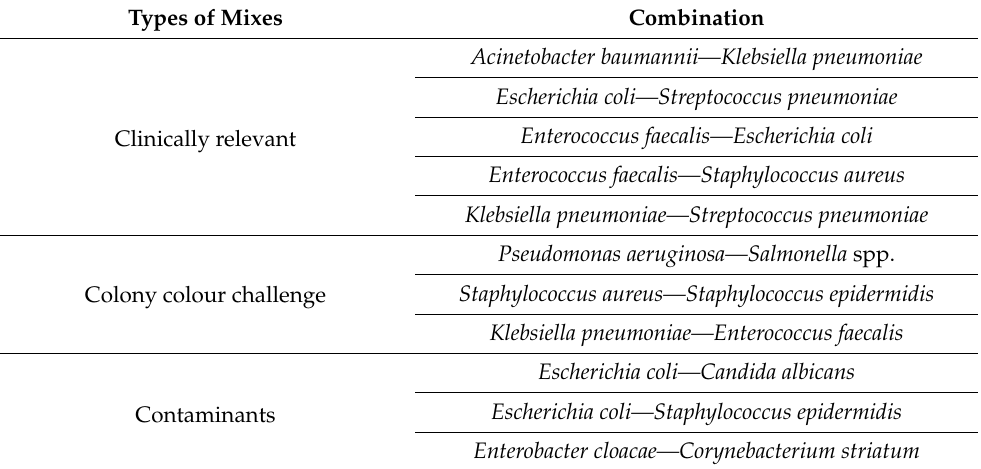
Table 2. Microbial types of mixes used for the